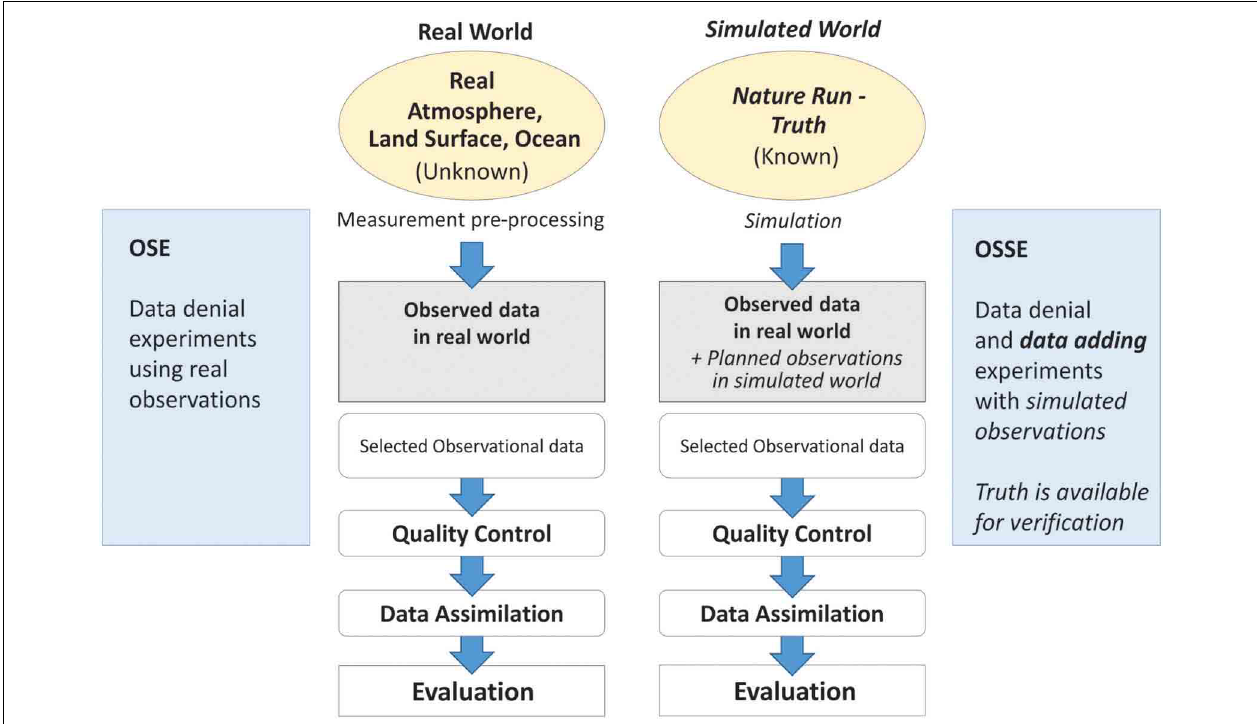
FIGURE 5 | Schematic of an observing system experiment, OSE (left-hand flow diagram), and an observing system simulation experiment, OSSE (right-hand flow diagram). See text for an explanation of the terms in the figure. Based on material in Masutani et al.